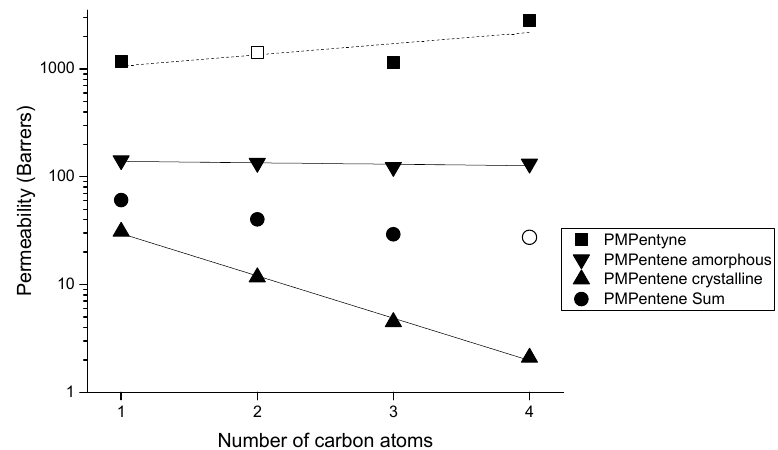
Figure 8. Permeability coefficients of PMPentyne and PMPentene (with amorphous-crystalline dispersion) at